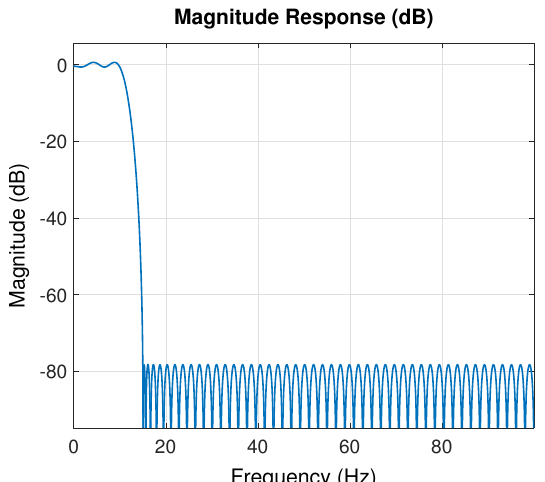
Figure 10. Frequency response from the designed filter using the Filter Design and Analysis Tool from